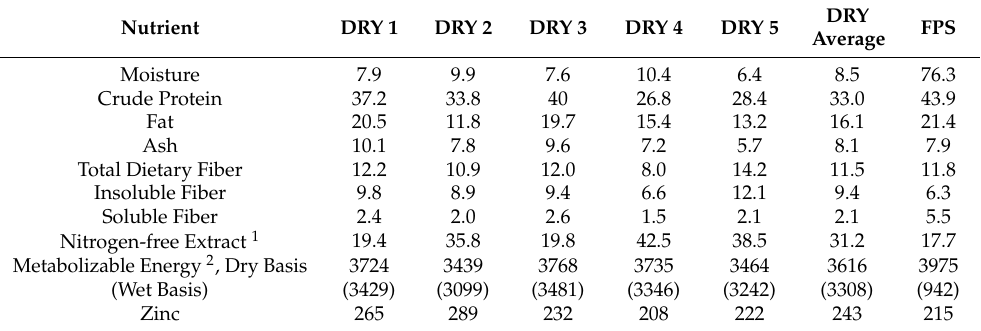
Table 2. Moisture and macro nutrient content on dry matter basis of the experimental diets (%), metabolizable energy data (kcal/kg diet), and zinc (mg/kg of diet on a dry matter basis).